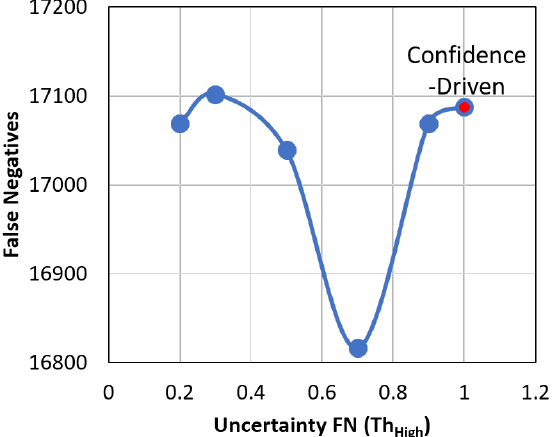
Figure 13. Number of False Negatives on the CAMEL dataset by sweeping the threshold for False Negatives th high . A value of 1.0 turns the system to purely confidence-driven.